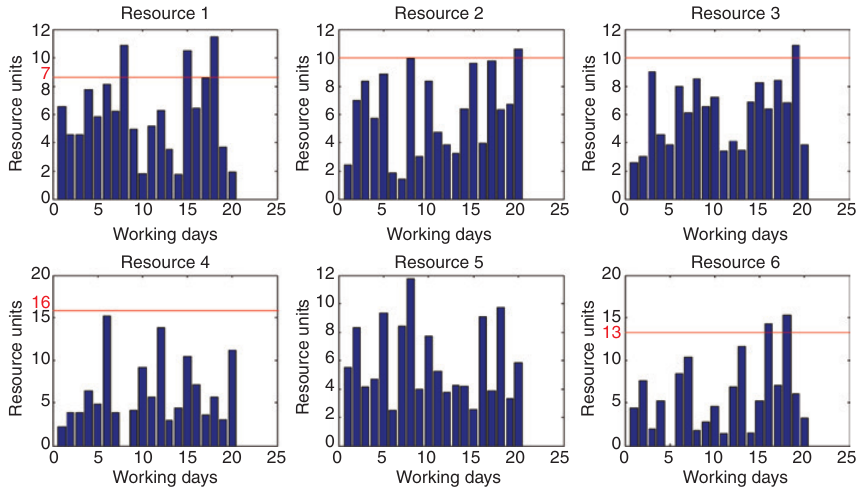
Figure 10: Resource Utilization with Resource Leveling.